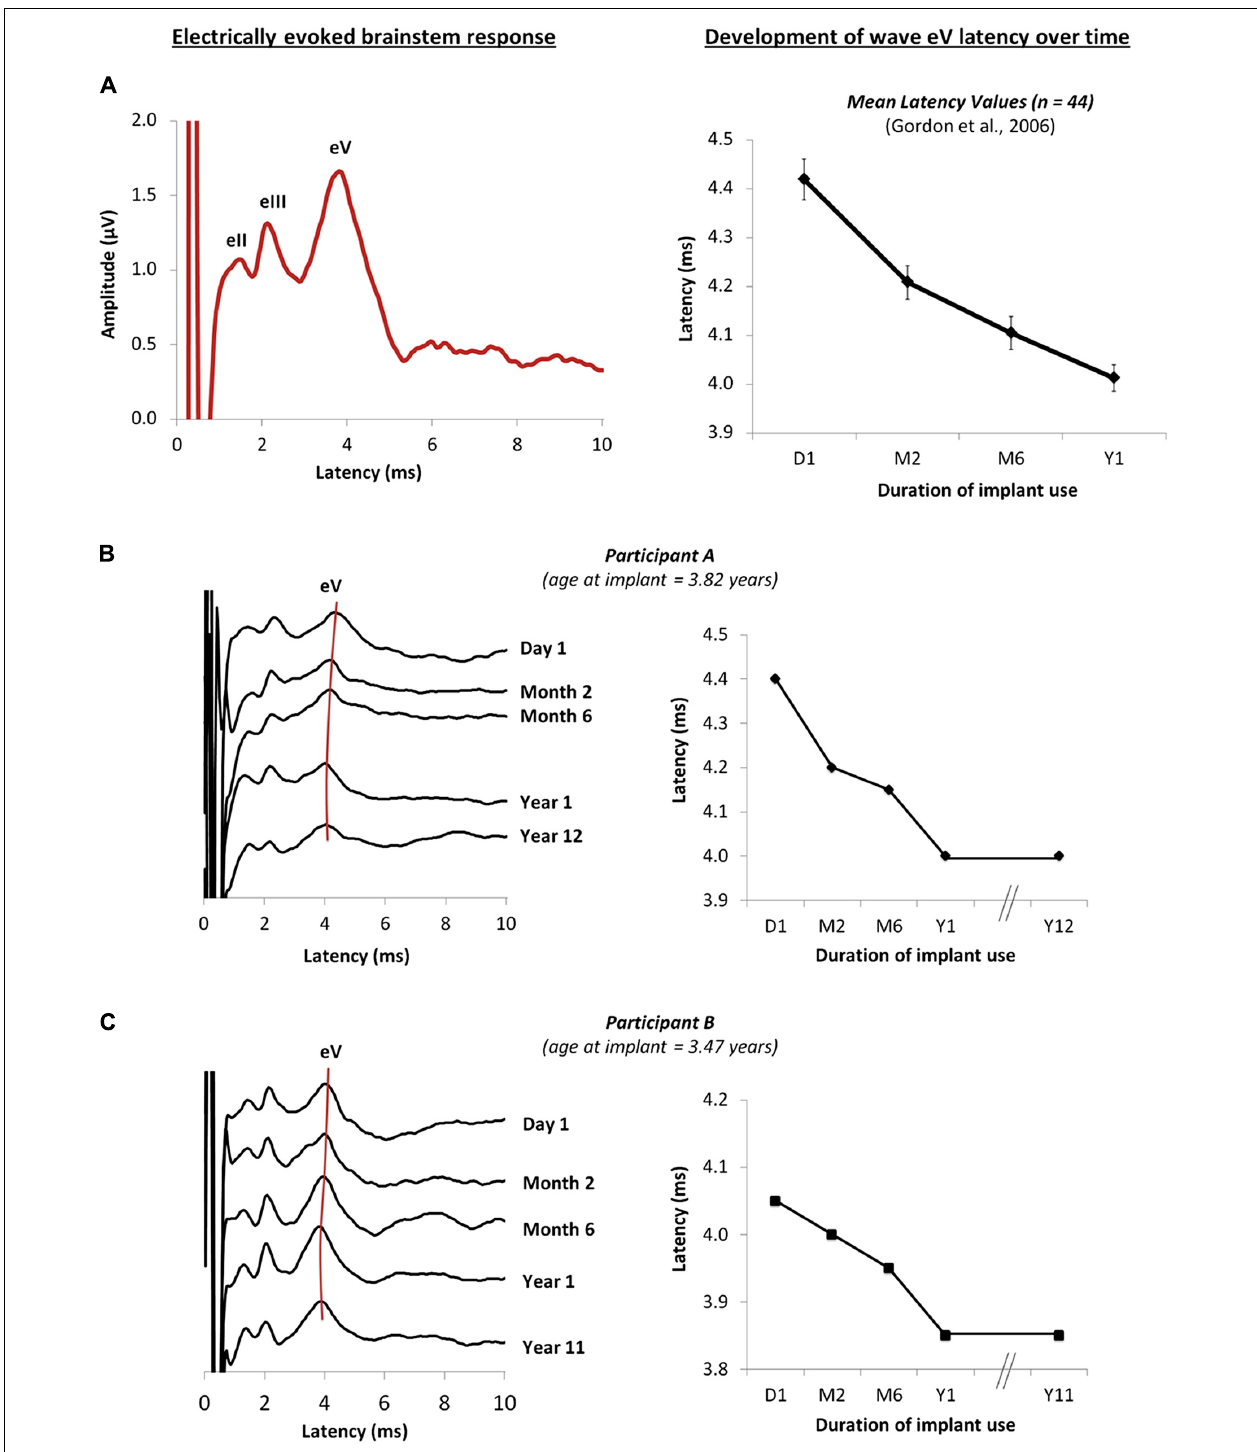
in the original study (Gordon etal., 2006), recorded from initial activation of the device to different intervals over the first year of cochlear implantation use. New responses recorded after 10 years of unilateral cochlear implant experience are also shown (Jiwani etal., 2011), further confirming that little change in the eV latency occurs beyond the first year of implant use.The wave eV latencies at each time-point are represented on the right for each